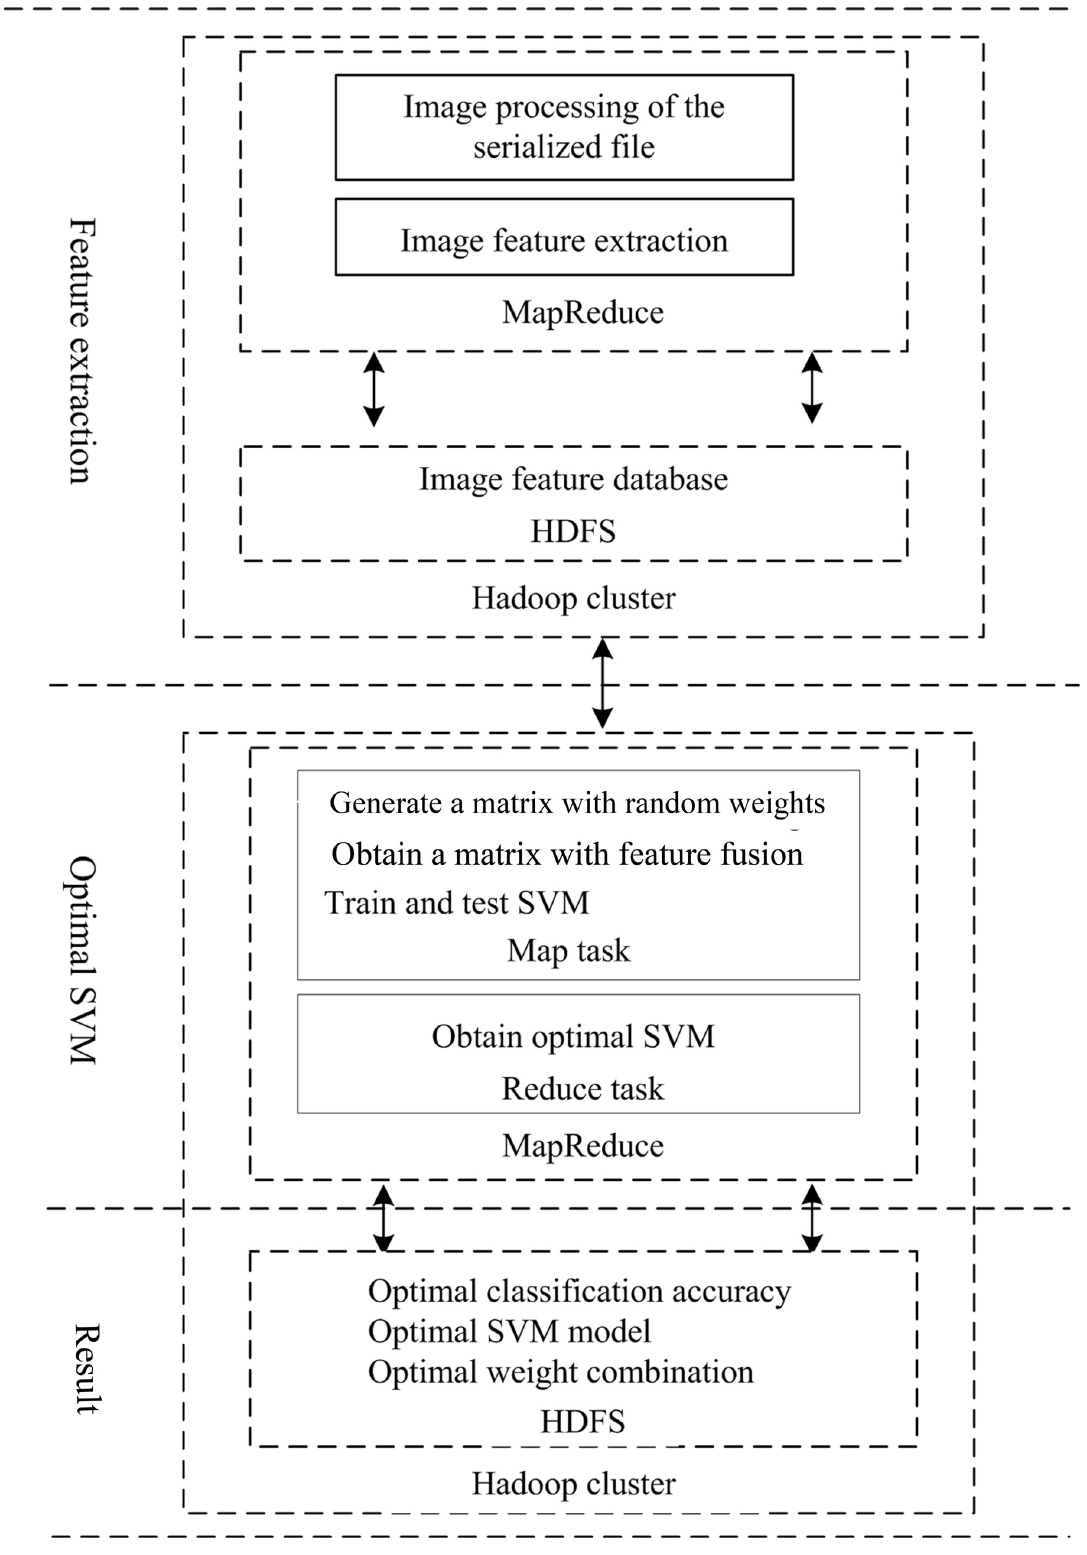
Fig 4. Overall framework of the PAFWU-SVM